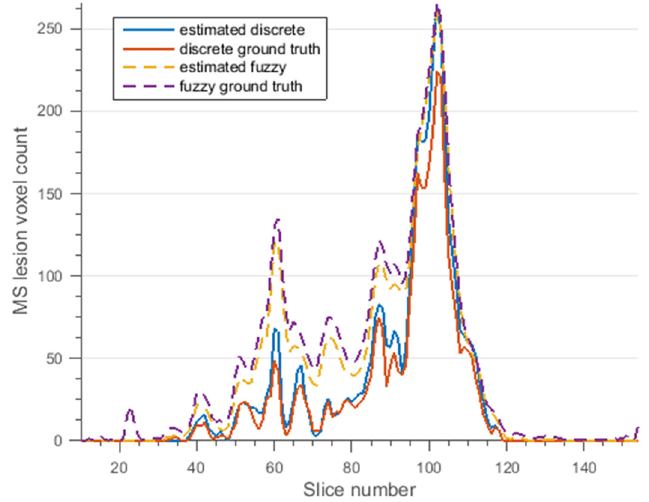
Figure 12. Moderate MS lesion cluster counts from discrete (solid) and fuzzy (dashed) estimates compared to ground truths, slice by slice, in the brain